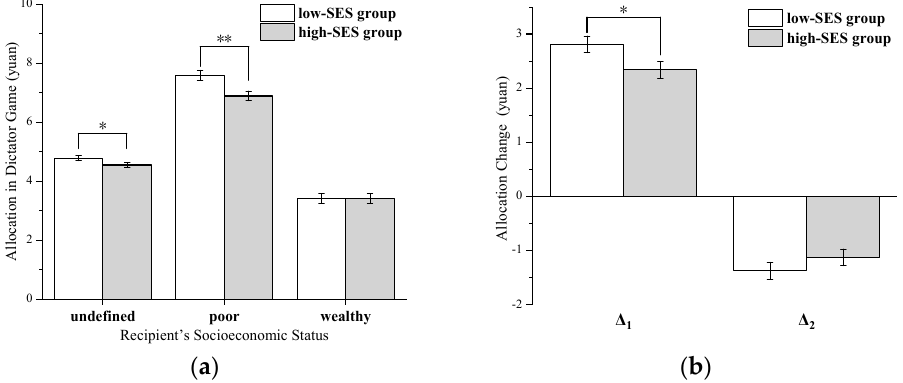
Figure 2. ( a ), Allocation of the dictators in the dictator game in three recipient conditions. ( b ) Allocation changes in two groups, ∆ 1 = allocation poor − allocation undefined , ∆ 2 = allocation wealthy − allocation undefined . * p < 0.05; ** p <